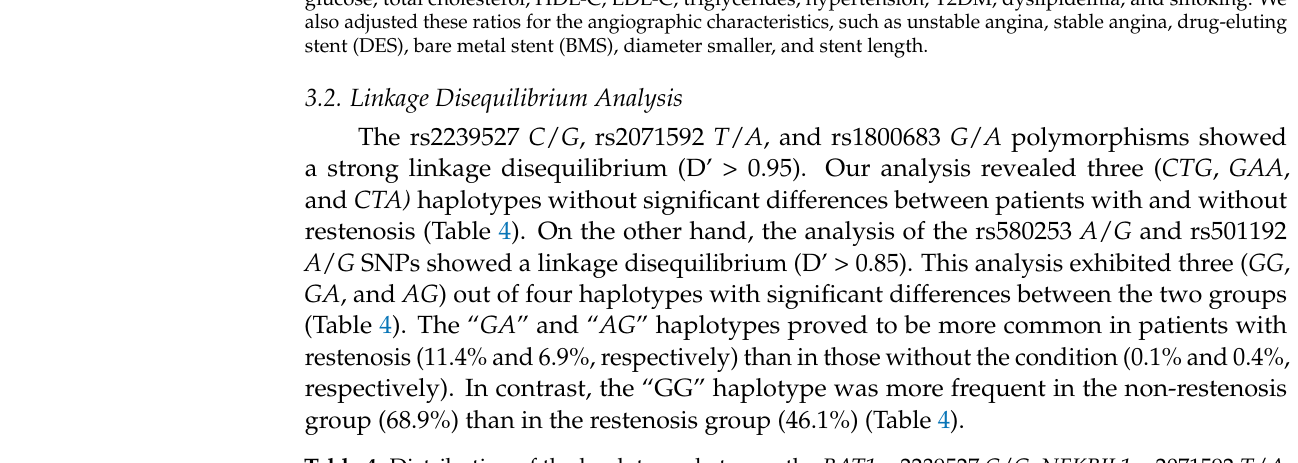
Table 4. Distribution of the haplotypes between the BAT1 rs2239527 C / G , NFKBIL1 rs2071592 T / A , and LTA 1800683 A / T polymorphisms, and the CASP1 rs501192 A / G and CASP1 rs580253 A / G polymorphisms in the study